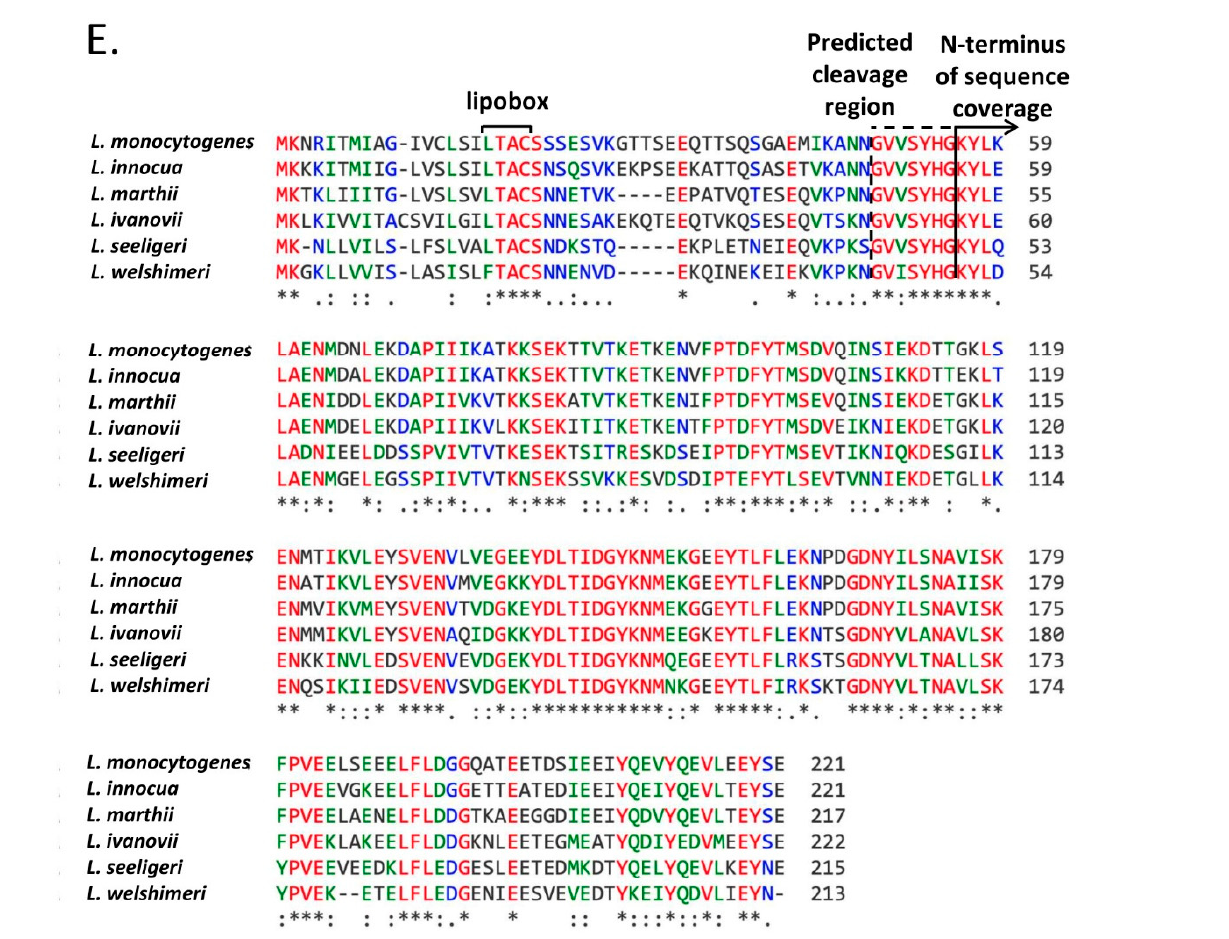
Figure 4. Tim is cleaved by Mtz. Western blot analysis of Tim and Mtz proteins 6His tagged at C-terminus, obtained from indicated bacterial strains grown to mid-log phase in BHI at 37 ◦ C. Total proteins were separated into the cytosolic ( A ), membrane ( B ) and supernatant fractions ( C , D ). Equal amounts of proteins in each fraction were separated on 12.5% SDS-PAGE, blotted and probed with anti-6His antibody. The experiment was performed 3 times, and the figure shows a representative blot. Tim cleavage products are marked with asterisks. ( E ) Multiple alignments of the Tim homologues of the clade Listeria sensu strictu species. The conserved N-terminal lipobox is indicated. The N-terminus of the sequence coverage of the purified cleaved Tim-His is marked by a plain line, and the predicted cleavage site is marked by a broken line. The following accession numbers were used for the alignment: AEO06250.1 (corresponds to gene tag LMRG_00714, L. monocytogenes strain 10403S); CAC96535.1 ( L. innocua ); EFR87930.1 ( L. marthii ); CBW85704.1 ( L. ivanovii ); MBC1942631.1 ( L. seeligeri ); CAK20663.1 ( L. welshimeri ). Deduced amino acid sequences were aligned using the ClustalW program (https://npsa-prabi.ibcp.fr/cgi-bin/npsa_automat.pl?page=/NPSA/npsa_clustalw.html, accessed on 1 June